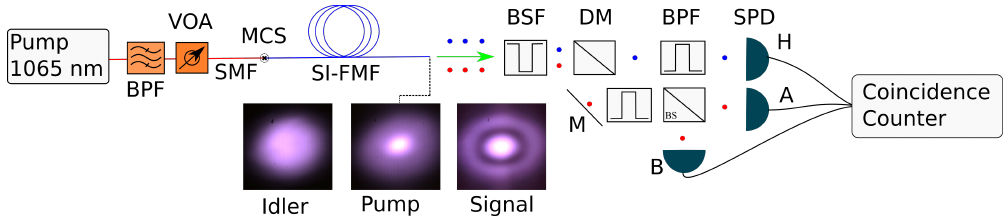
Figure 2. Experimental setup: BPF: bandpass filter, SMF: single-mode fiber SI-FMF step-index few-mode fiber, BSF: bandstop filter, DM dichroic mirror, M: mirror, SPDs: single-photon